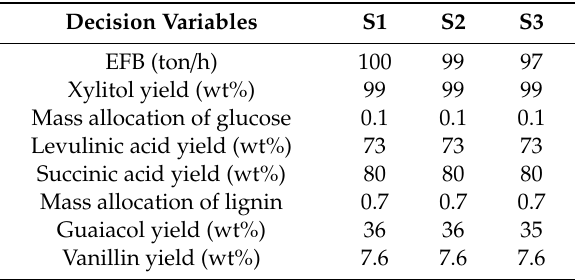
Figure 5. Pareto-optimal front for profit versus global warming potential. Table 7. Decision variables that correspond to the selected Pareto-optimal points in Figure 5.